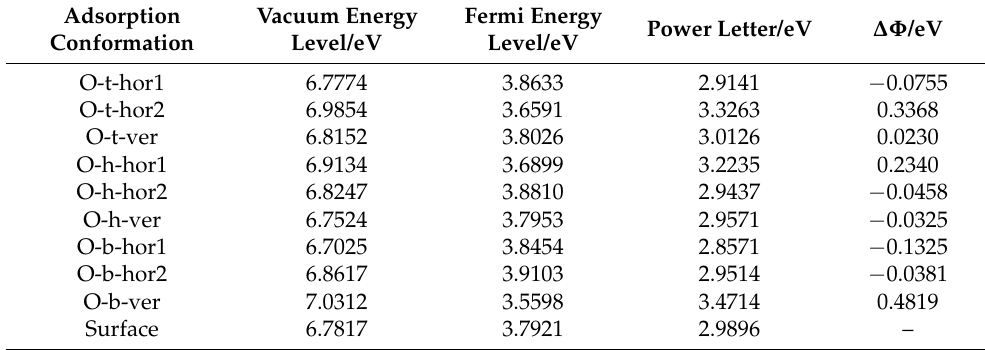
Table 3. Variation of surface work function for different adsorption configurations ( ∆Φ ).